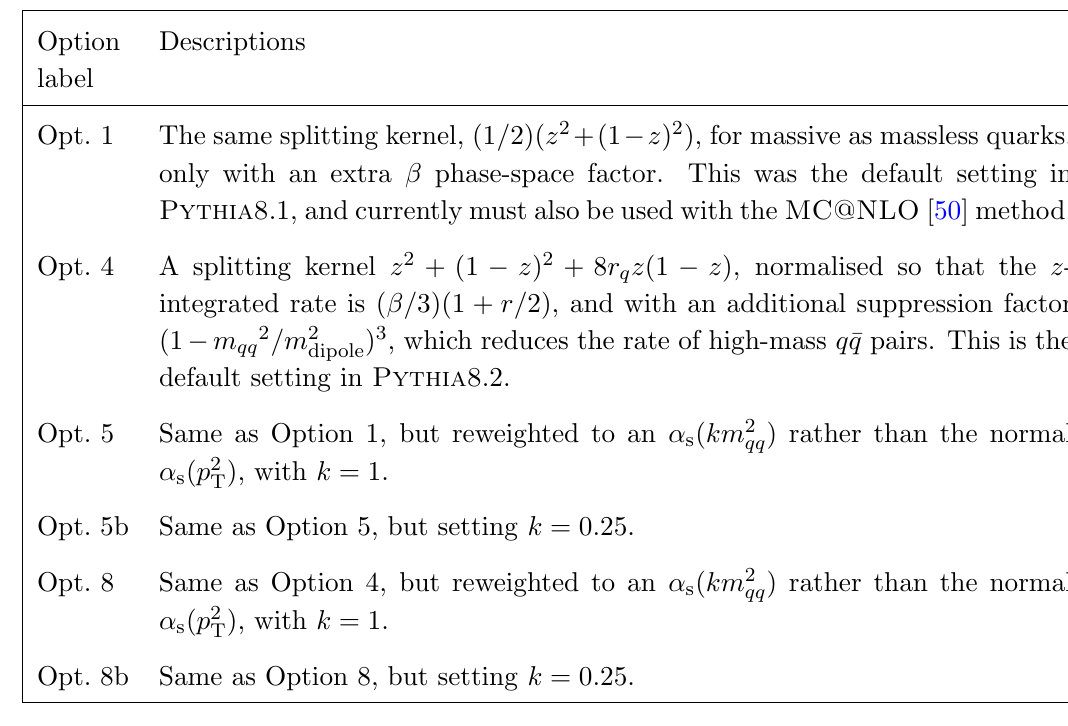
Table 1 . Description of Pythia8 options. Options 2, 3, 6 and 7 are less well physically motivated and not considered here. The notation used is as follows: r q = m 2 the quark mass and m qq the q (cid:22) q pair invariant